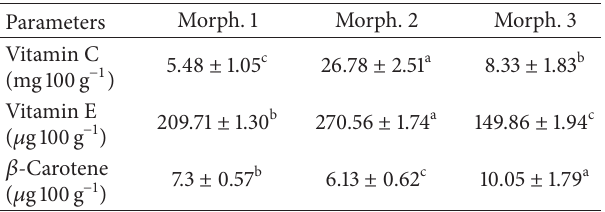
Table 4: Fatty acid composition (% total fatty acids) of total lipid from Cyperus esculentus morphotypes tubers’